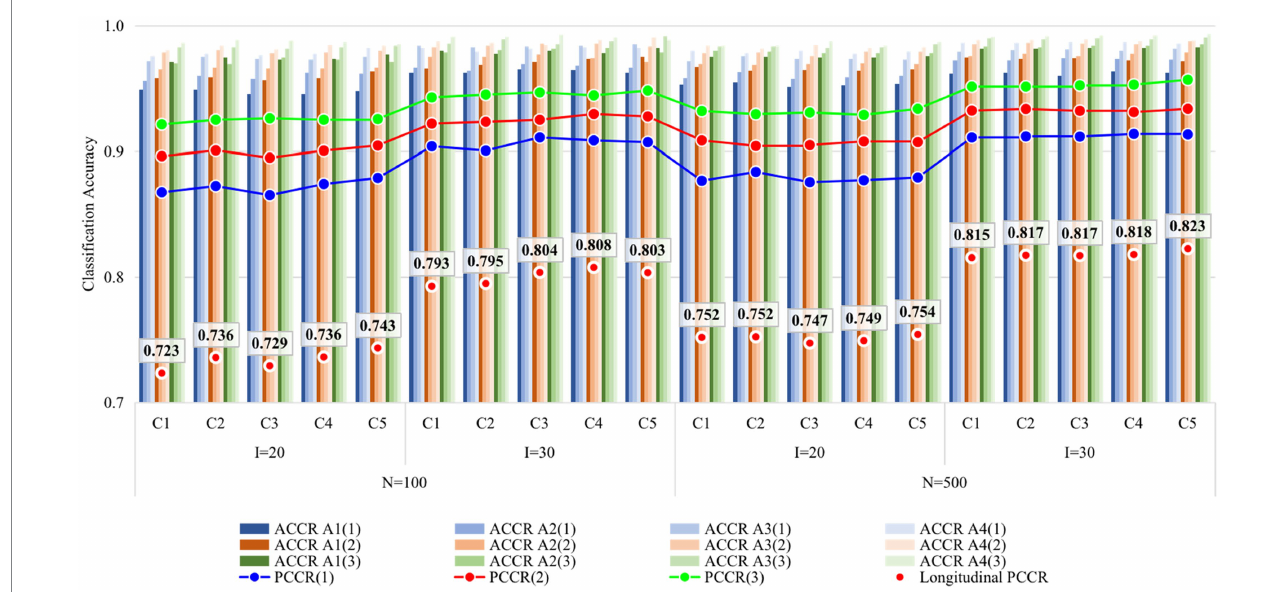
FIGURE 2 Recovery of attributes in Study 1. I, number of items; N, sample size; Occasion is in parentheses; C1, four items outside R were set as anchor items; C2, four items inside R were set as anchor items; C3, eight items outside R were set as anchor items; C4, four items inside and four items outside R were set as anchor items; C5, eight items inside two Rs were set as anchor items; R, unit Q-matrix. ACCR, attribute correct classification rate; PCCR, attribute pattern correct classification rate on each occasion (4 attributes); Longitudinal PCCR, PCCR on all three occasions (12 attributes).